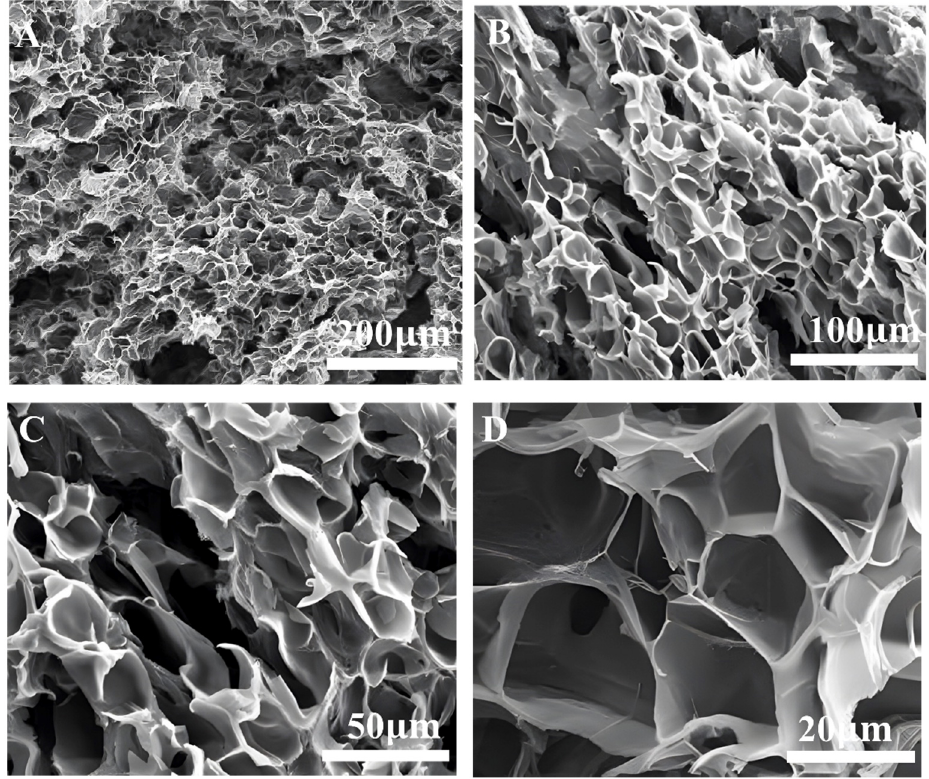
Figure 6. SEM images of ZJL-1. ( A ). 200 Um; ( B ). 100 um; ( C ). 50 um; ( D ). 20 um